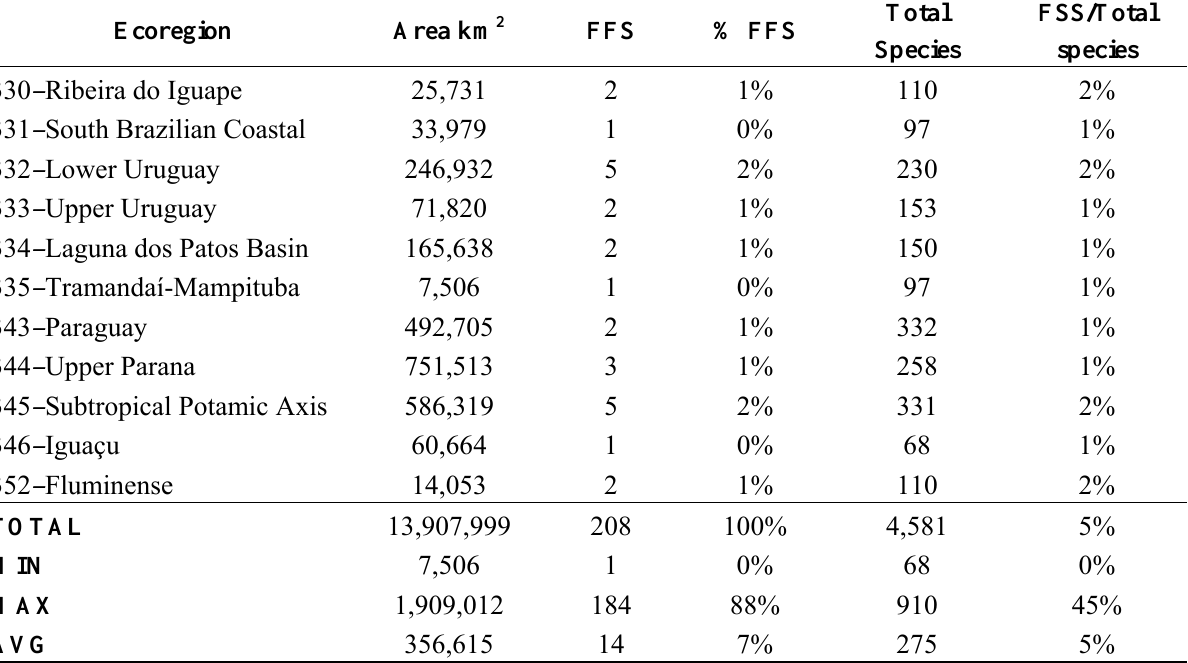
Figure 9. Geographic distributions of 208 Fitzcarrald fish species (FFS) among freshwater ecoregions (ER) of tropical South America. Black line indicates Amazon Basin watershed. (A) Total number of FFS per ecoregion. (B) Percent of FFS pool in that ecoregion. Data from Table 1. Note high numbers and proportions of FFS in the adjacent